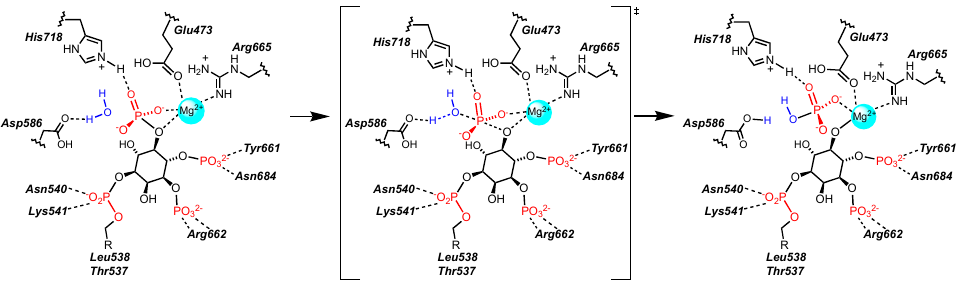
Figure 5. Catalysis of the cleavage of the 5 ′ -phosphate of PI(3,4,5)P 3 by SHIP2.